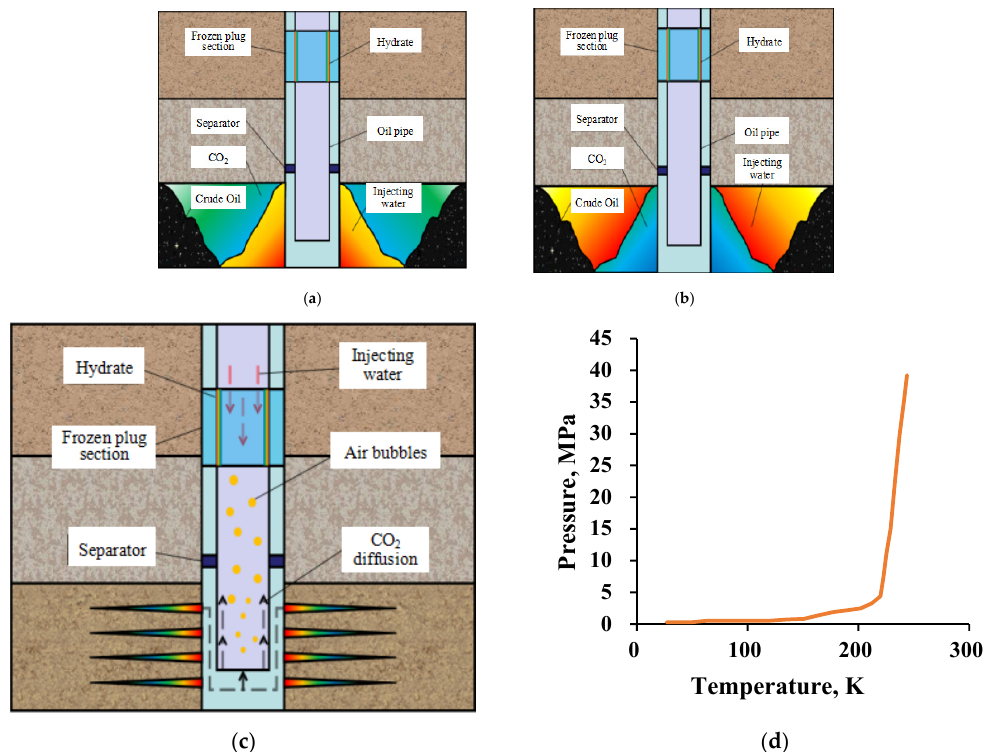
Figure 1. Classification of hydrate plugging in supercritical CO 2 and water alternative injection wells, and CO 2 phase equilibrium curve. ( a ) During water injection before and after well shut-in; ( b ) During gas injection before and after shut-in; ( c ) During normal water injection; ( d ) Carbon dioxide phase equilibrium curve.